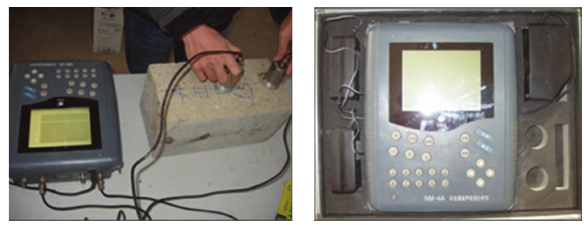
Figure 1: NM-4 nonmetal ultrasonic tester.